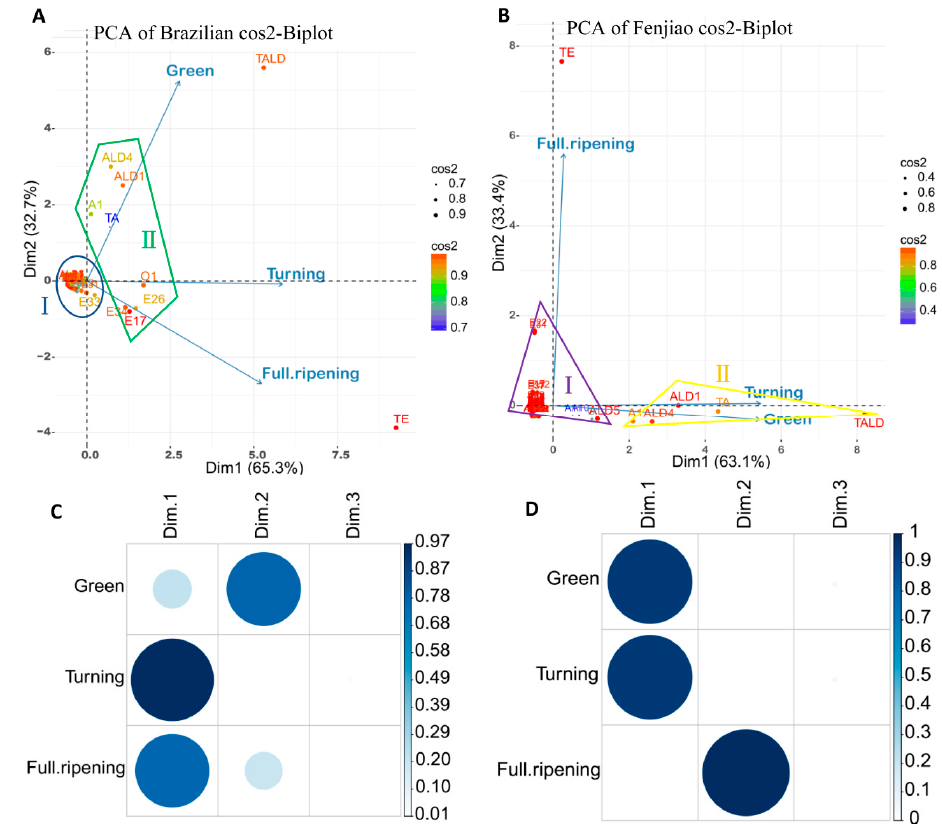
Figure 2. Overview of volatiles profiles of two banana varieties. ( A , B ) Biplot of PCA analysis described in the banana varieties (Brazilian and Fenjiao) of all variables during the three fruit ripening stages. ( C , D ) The cos2 of volatiles compounds at three ripening stages on all the dimensions for Brazilian and Fenjiao, respectively. Different volatiles were characterized by PCA, and the code in ( A , B ) were listed in Supplemental Table S1. Dim: Direction, which indicated the principal component (PC). PCA analysis was conducted and visualized using R software. The cos2 of variables on all the dimensions using the corrplot package. A high cos2 indicates a good representation of the variable on the principal component.